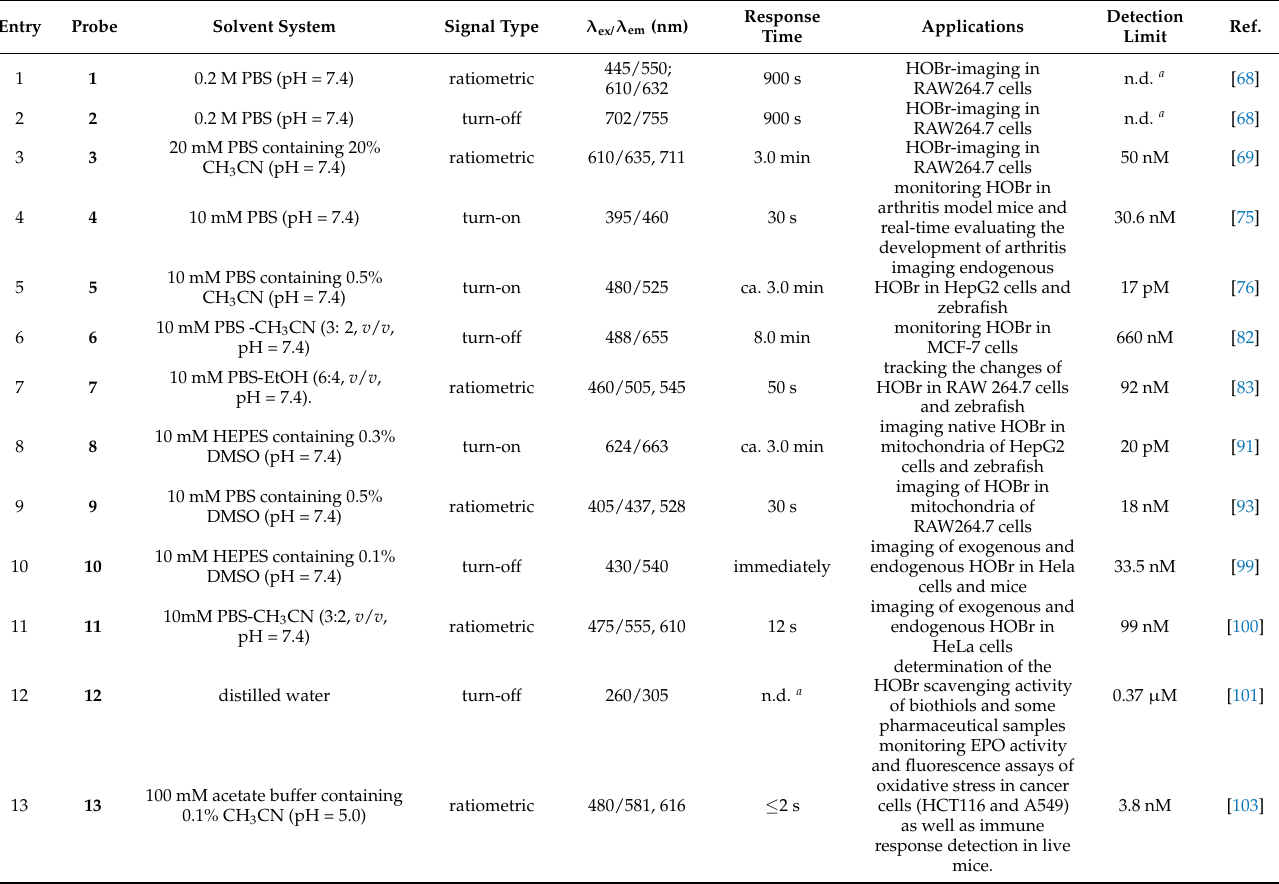
Table 1. Summary of the fluorescent probes for